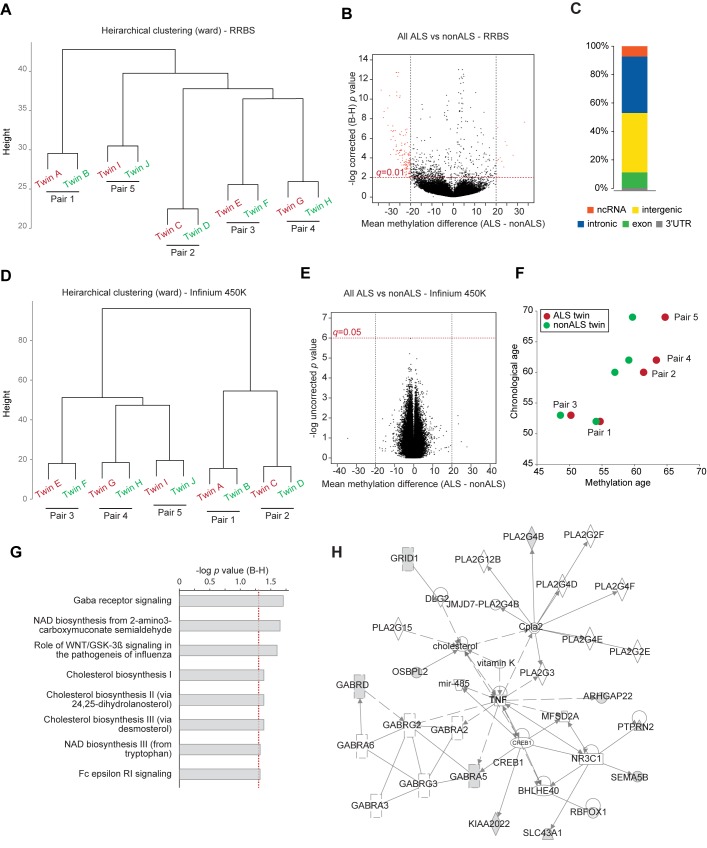
RRBS reveals commonly differentially methylated CpGs in ALS cases that cluster in GABA receptor signaling.(A) Dendrogram showing unsupervised hierarchical clustering of RRBS data at 10x coverage; ALS affected twin in red, nonALS co-twin in green. (B) Volcano plot showing mean methylation difference between ALS cases and controls (x-axis) versus -log corrected p values (y-axis) for CpG sites present in all RRBS libraries. Sites called as differentially methylated (at 20x coverage, 20% difference, q<0.01) are in red. (C) Genomic annotation of sites called as differentially methylated in (B). ncRNA: non-coding RNA. (D) Dendrogram showing unsupervised hierarchical clustering of Infinium 450K data. (E) Volcano plot showing mean methylation difference between ALS cases and controls (x-axis) versus -log uncorrected p values (y-axis) for all CpG sites present on the 450K array. (F) Plot showing chronological age versus methylation age for each twin pair; ALS affected twin in red, nonALS co-twin in green. (G) Top canonical pathways represented by the genes harbouring differentially methylated cytosines between ALS cases and controls. (H) Ingenuity Pathway Analysis network related to GABR signaling; genes harbouring differentially methylated cytosines are shaded grey.